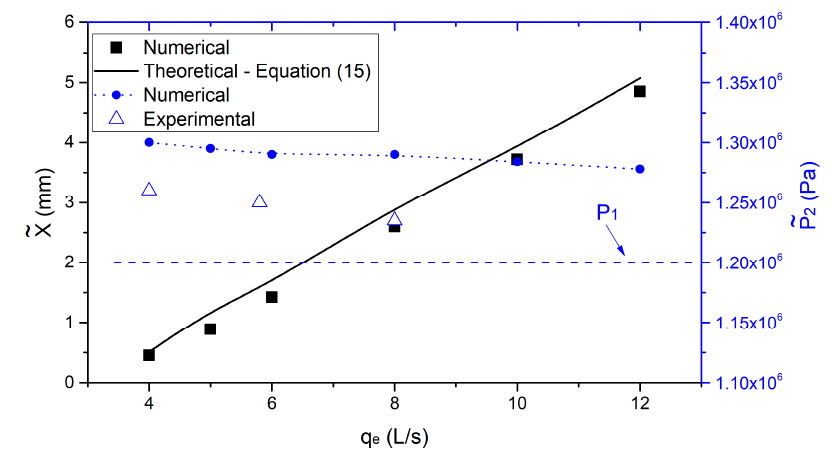
Figure 11. Variation of the equilibrium poppet displacement (cid:101) X and outlet pressure (cid:102) P 2 versus the inlet flow rate ( q e ) for P 1 = 1.2 MPa.